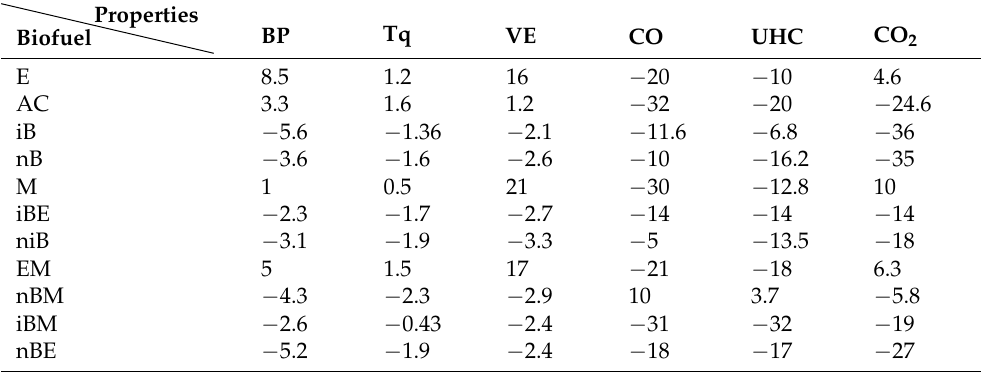
Table 2. Performance and emissions of single and dual alcohol blends.